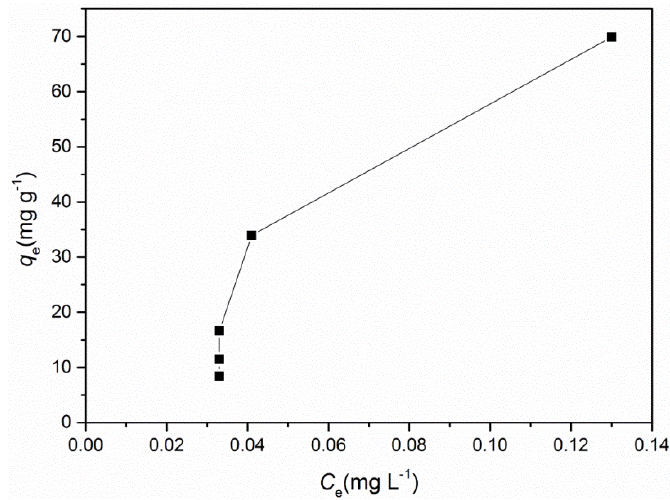
Figure 3. The adsorption isotherm for selenate by the A-LMS Fe 3 O 4 adsorbent; experimental condi- tions: the adsorbent dose was set at 0.23 g L −1 , pH 6.46, temperature 22 °C and stirring 170 rpm.